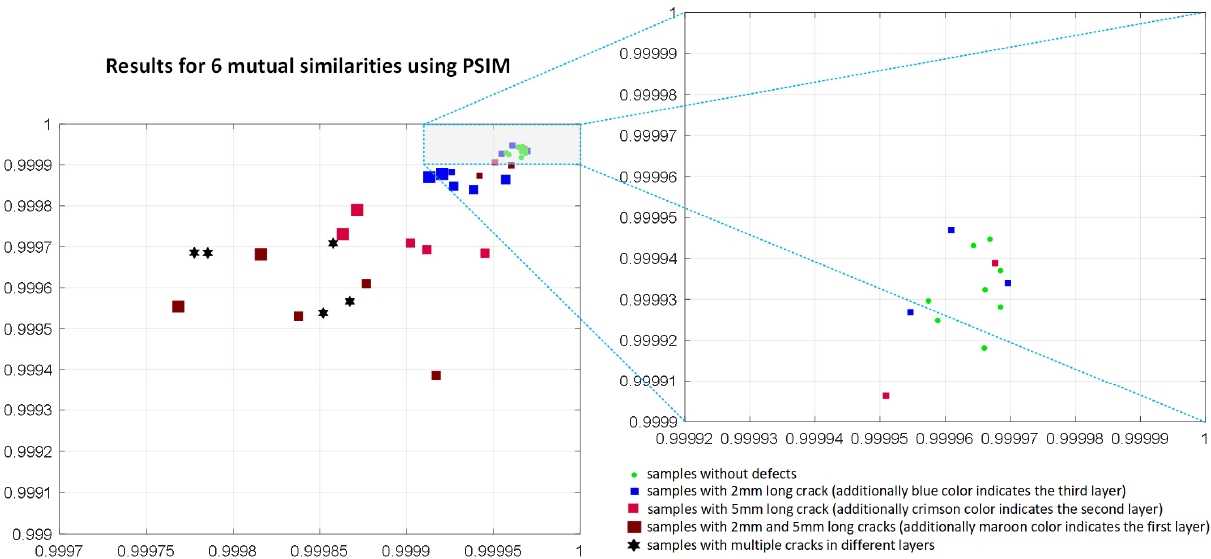
Figure 18. Results obtained applying six mutual comparisons employing the PSIM metric using the maximum and average of its values calculated for 17 images corresponding to various frequencies used in experiments.